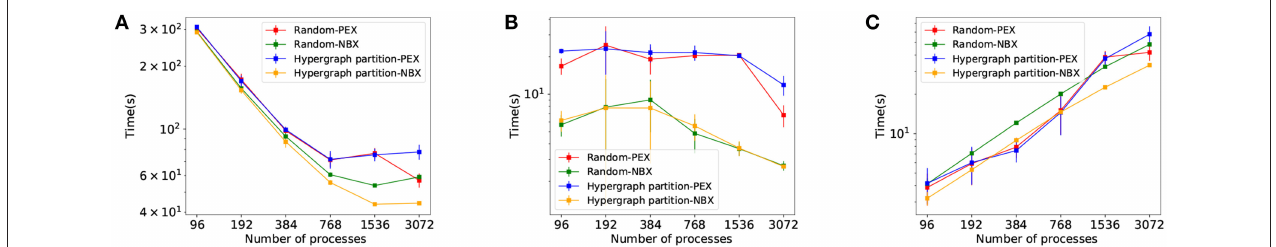
FIGURE 10 | Simulation results of the MVC model showing performance improvements of HB-NBX over the baseline round robin-PEX . The top part of the figure displays connectivity-related metrics. (A) Data volume exchanged during simulation; (B) Average runtime neighbors in communication phases reduction in percentage. The bottom part of the figure shows results of the MVC scaling experiments with both alternatives. (C) Computation time which decreases linearly, demonstrating the potential benefit of increased parallelism; (D) Data exchange time; (E) Implicit synchronization time; (F) Total simulation time.